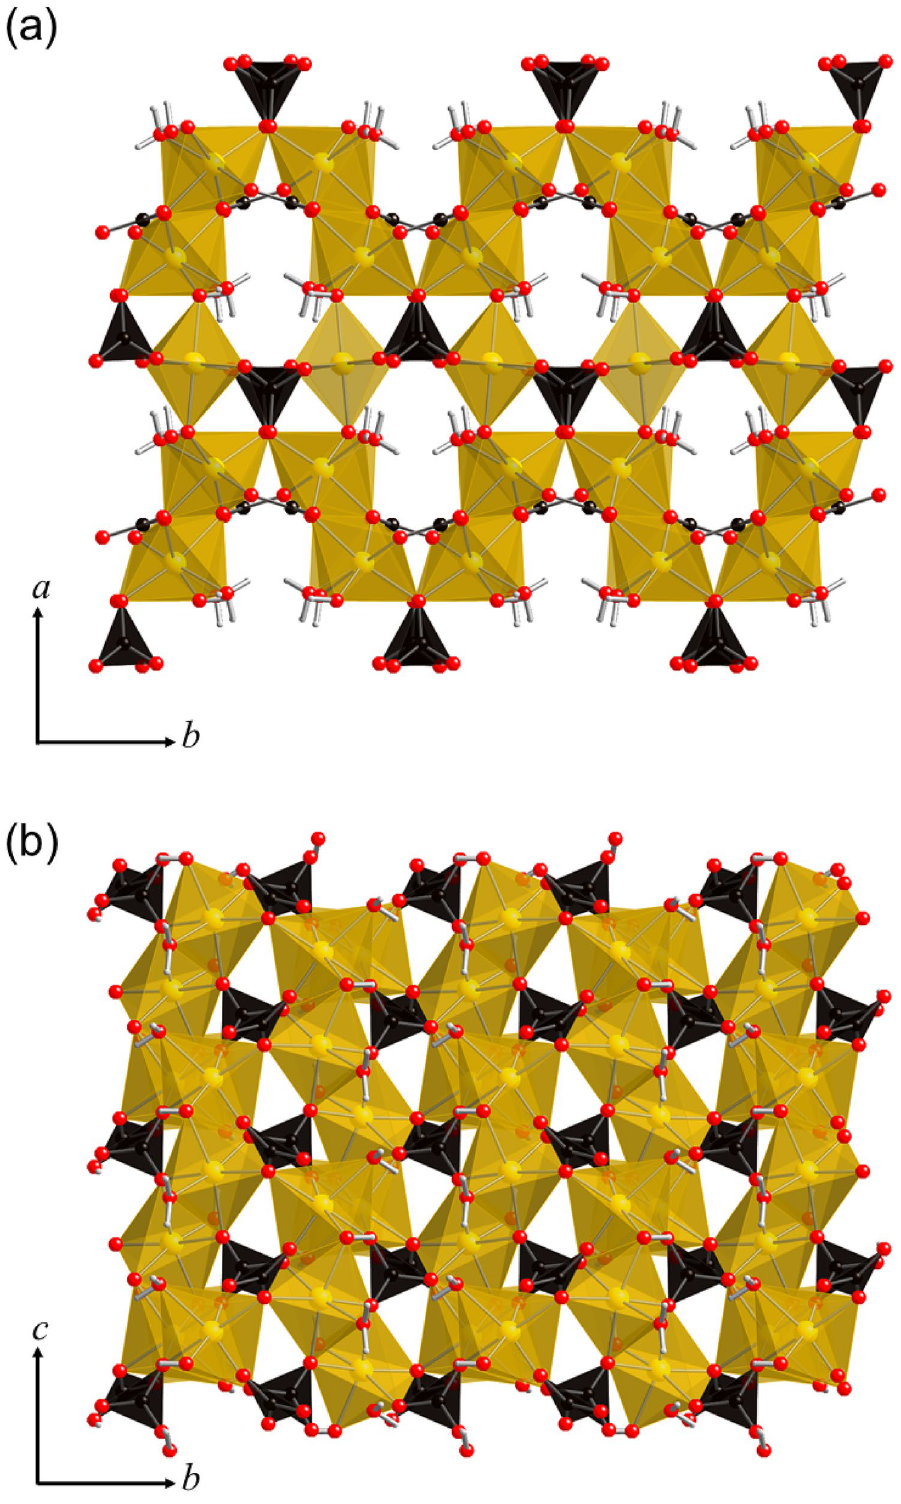
Figure 2. Crystal structure of hydromagnesite [Mg 5 (CO 3 ) 4 (OH) 2 ·4H 2 O] projected along the (a) c - and (b) a -axes 10 . Yellow polyhedra and black triangles represent MgO 6 octahedra and CO 3 groups, respectively. Red and small white spheres denote oxygen and hydrogen atoms, respectively. The crystal structure images were generated using CrystalMaker ®